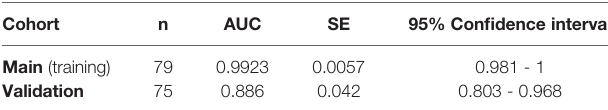
TABLE 3 | AUC values of the logistic regression model built with data from the main cohort and validated with data from the validation cohort. Cohort n AUC